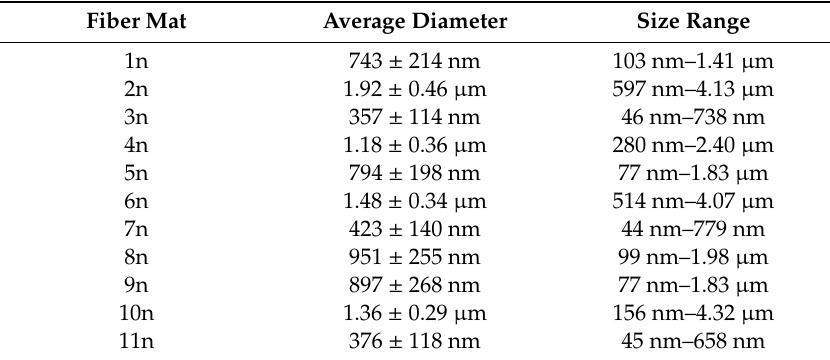
Figure 2. SEM images and average diameter distribution histograms of ( a ) 1n, ( b ) 2n, ( c ) 3n, ( d ) 4n, ( e ) 5n, ( f ) 6n, ( g ) 7n, ( h ) 8n, ( i ) 9n, ( j ) 10n, and ( k ) 11n fibers. Table 3. Average diameter and size range of the produced fiber